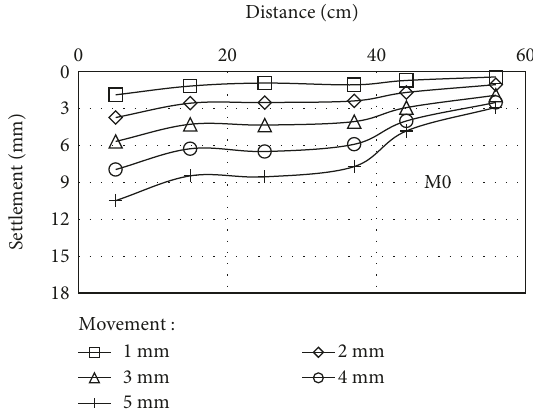
Figure 4: LVDTs measured settlement of the soil surface in sample M0.